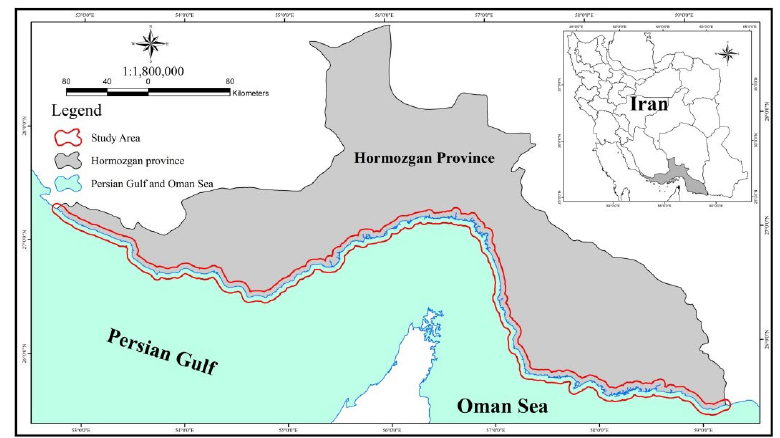
Fig. 1: The geographical location of the Hormozgan province as the study area